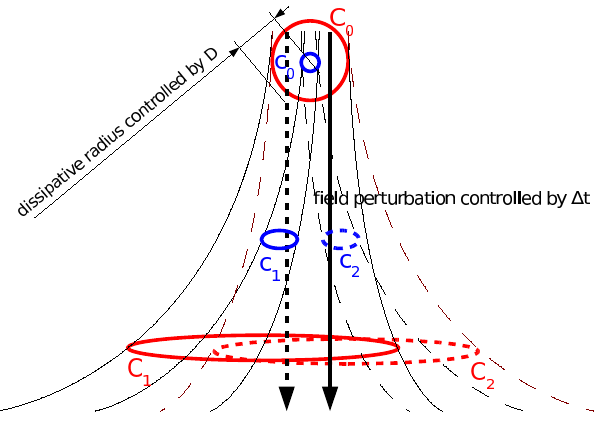
Fig. 3. Schematic on structural stability: qualitative different behaviors occur when the ratio between dissipative (initial) blob radius (associated with D ) and the scale of wind field perturbation is smaller (blue, lower case ‘c’) or larger (red, capital ‘C’) than 1. The perturbation is here the displacement of the separatrix associated with the stable manifold of an hyperbolic point. The solid lines are the unperturbed case while the dashed lines correspond to the perturbed field, that we assume resulting from the increase in time resolution. If the relative size of the blob with respectto the perturbation is small, the separatrix passes acrossthe blob and the evolution changes significantly, whereas if the relative size is large, the change is only moderate.